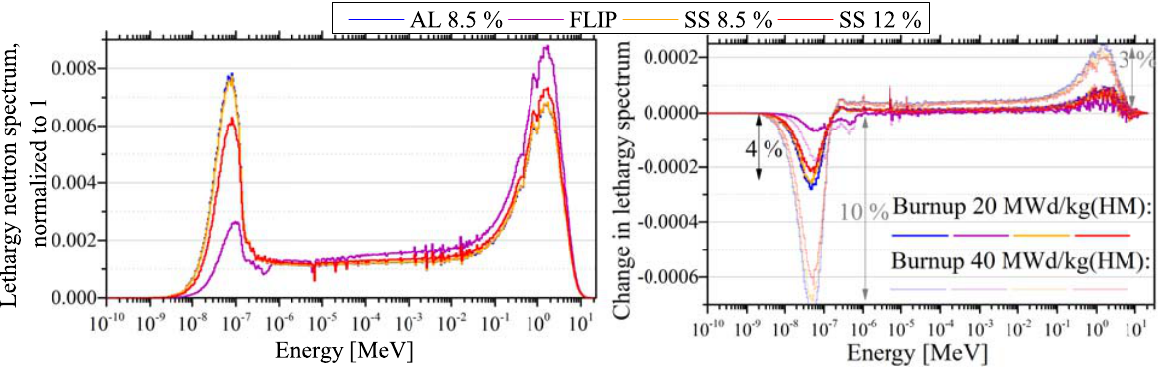
Figure 5: Neutron lethargy spectrum in different types of TRIGA fuel unit-cells (left). Analysis of spectrum changes on two different burnups